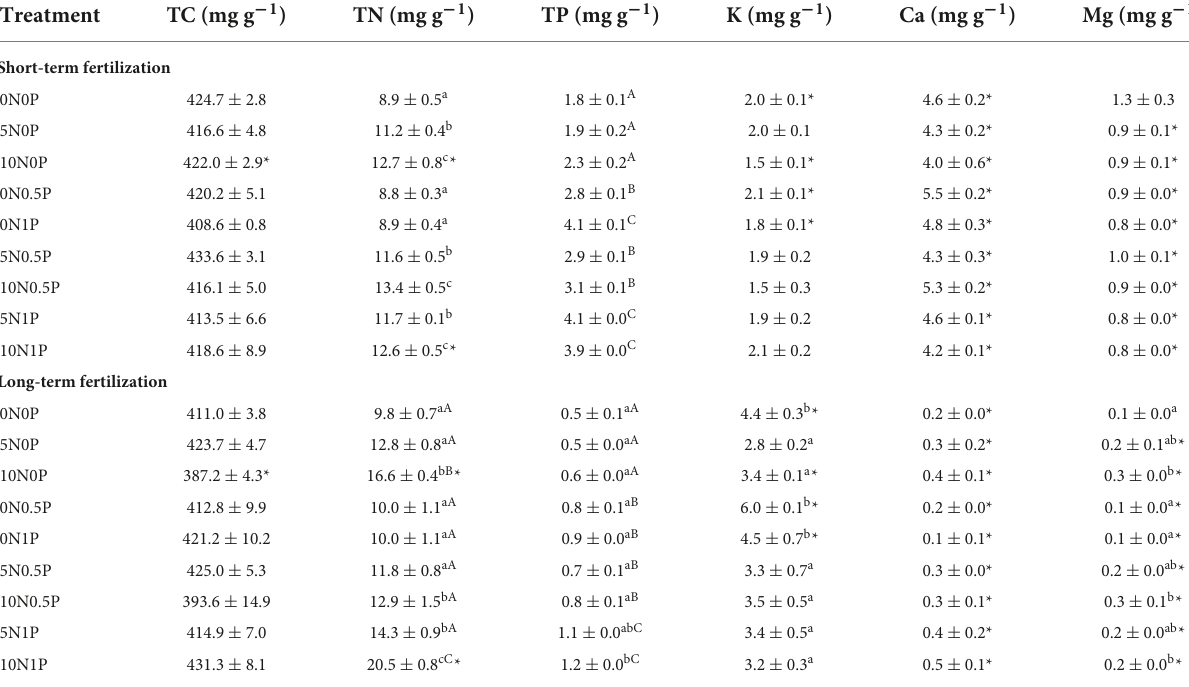
TABLE 1 Peat chemical properties under different treatments in the short- and long-term fertilizations.